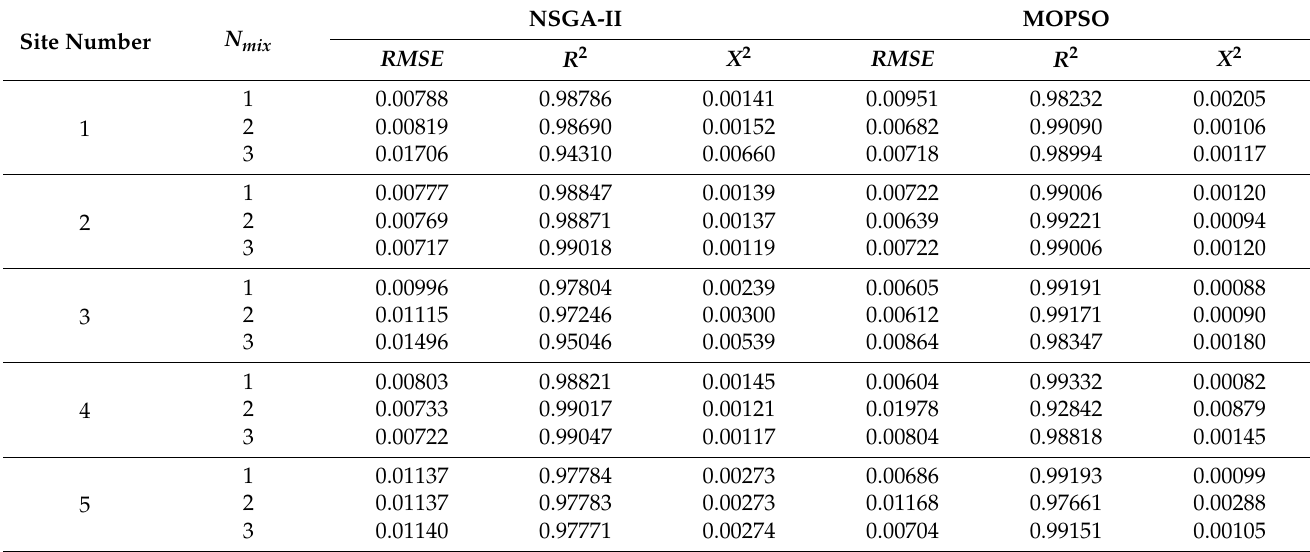
Table 7. Results obtained for variable wind speed spacings in the five Egyptian